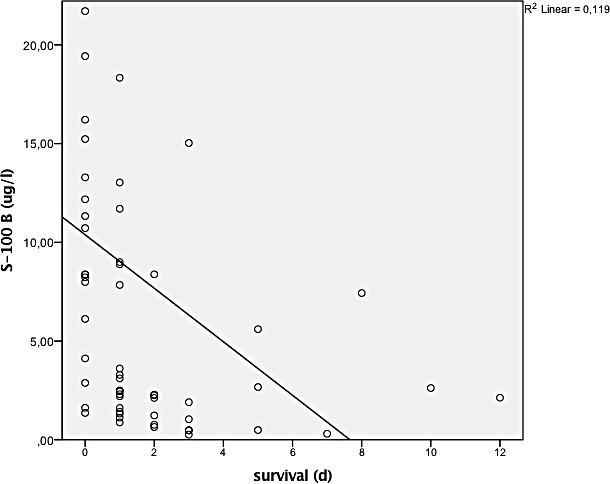
Correlation between survival und S-100 B concentration (p< 0.0001).